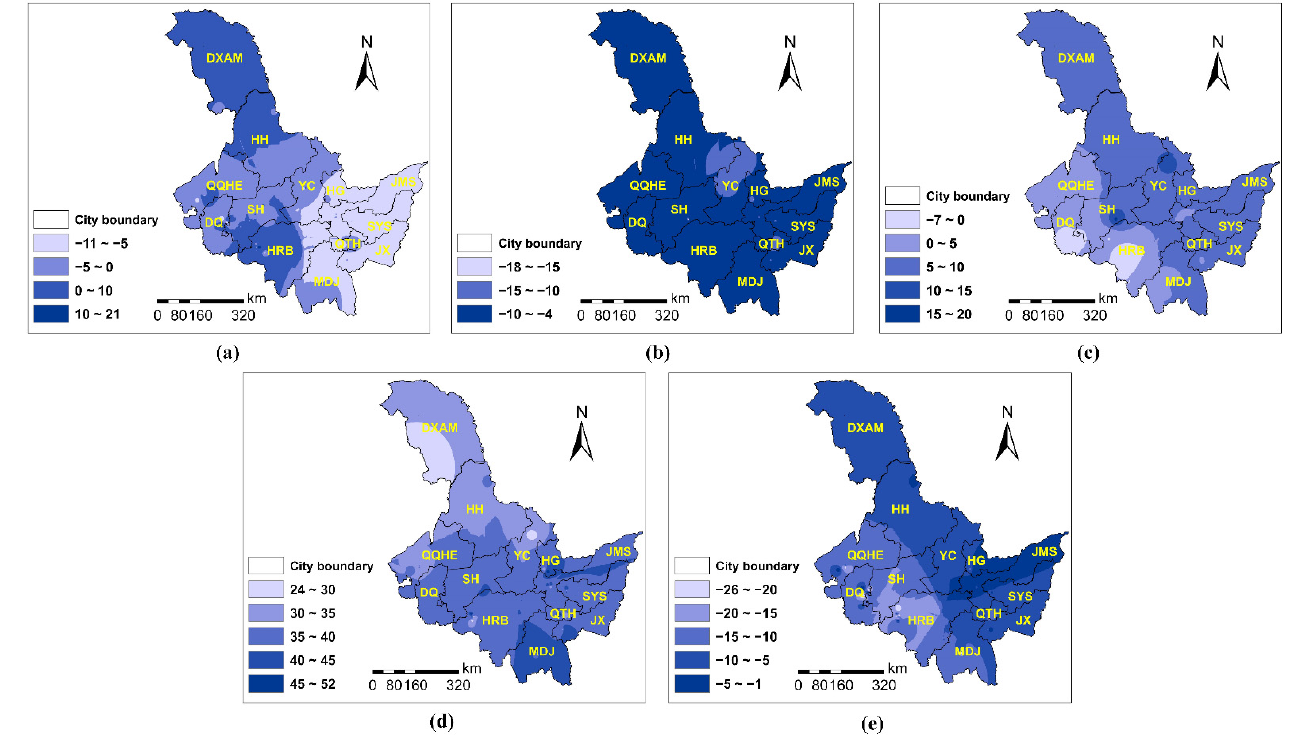
Figure 3. The PCA-GTWR parameter estimates of PM 10 interpolated by IDW: ( a ) PC1 (temperature); ( b ) PC2 (wind speed); ( c ) PC3 (pressure); ( d ) PC4 (atmospheric pollutant); ( e ) PC6 (vegetation